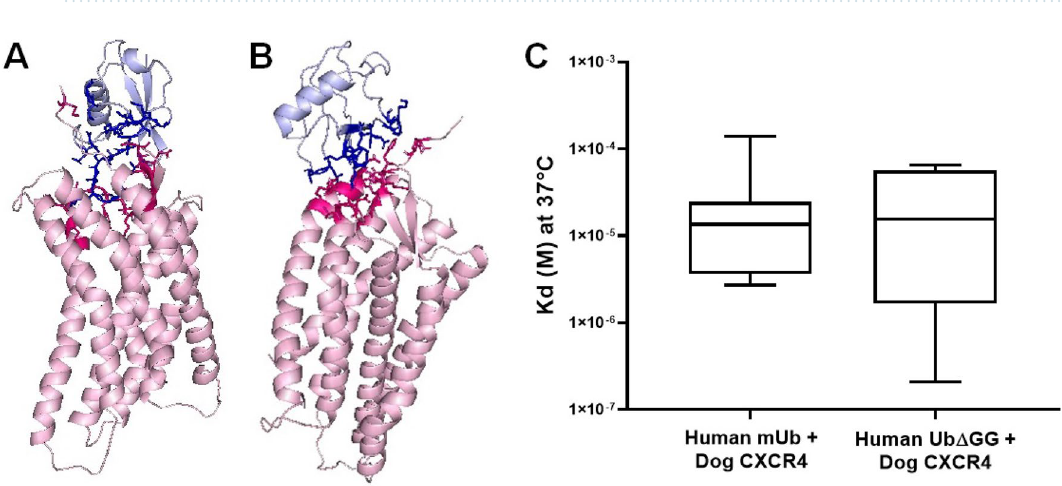
Figure 6. In silico analysis of binding of dog CXCR4 with mUb or Ub∆GG. The coupling analysis of dog CXCR4 with mUb ( A ) or Ub∆GG ( B ) was carried out on the ClusPro 2.0 server. Dog CXCR4 is shown in pink and mUb or Ub∆GG in blue. Dark pink or dark blue indicate the interface area between dog CXCR4 with mUb or Ub∆GG, respectively. The coupling visualization was done with PyMOL v2.0 ( C ), and the value of the dissociation constant (Kd) at 37 °C was assessed from the data obtained with ClusPro and the PRODIGY server. No statistical differences were found between the molecular coupling between the dog CXCR4 with any version of ubiquitin. The graph shows the median + interquartile range obtained in the statistical analysis using the Mann–Whitney